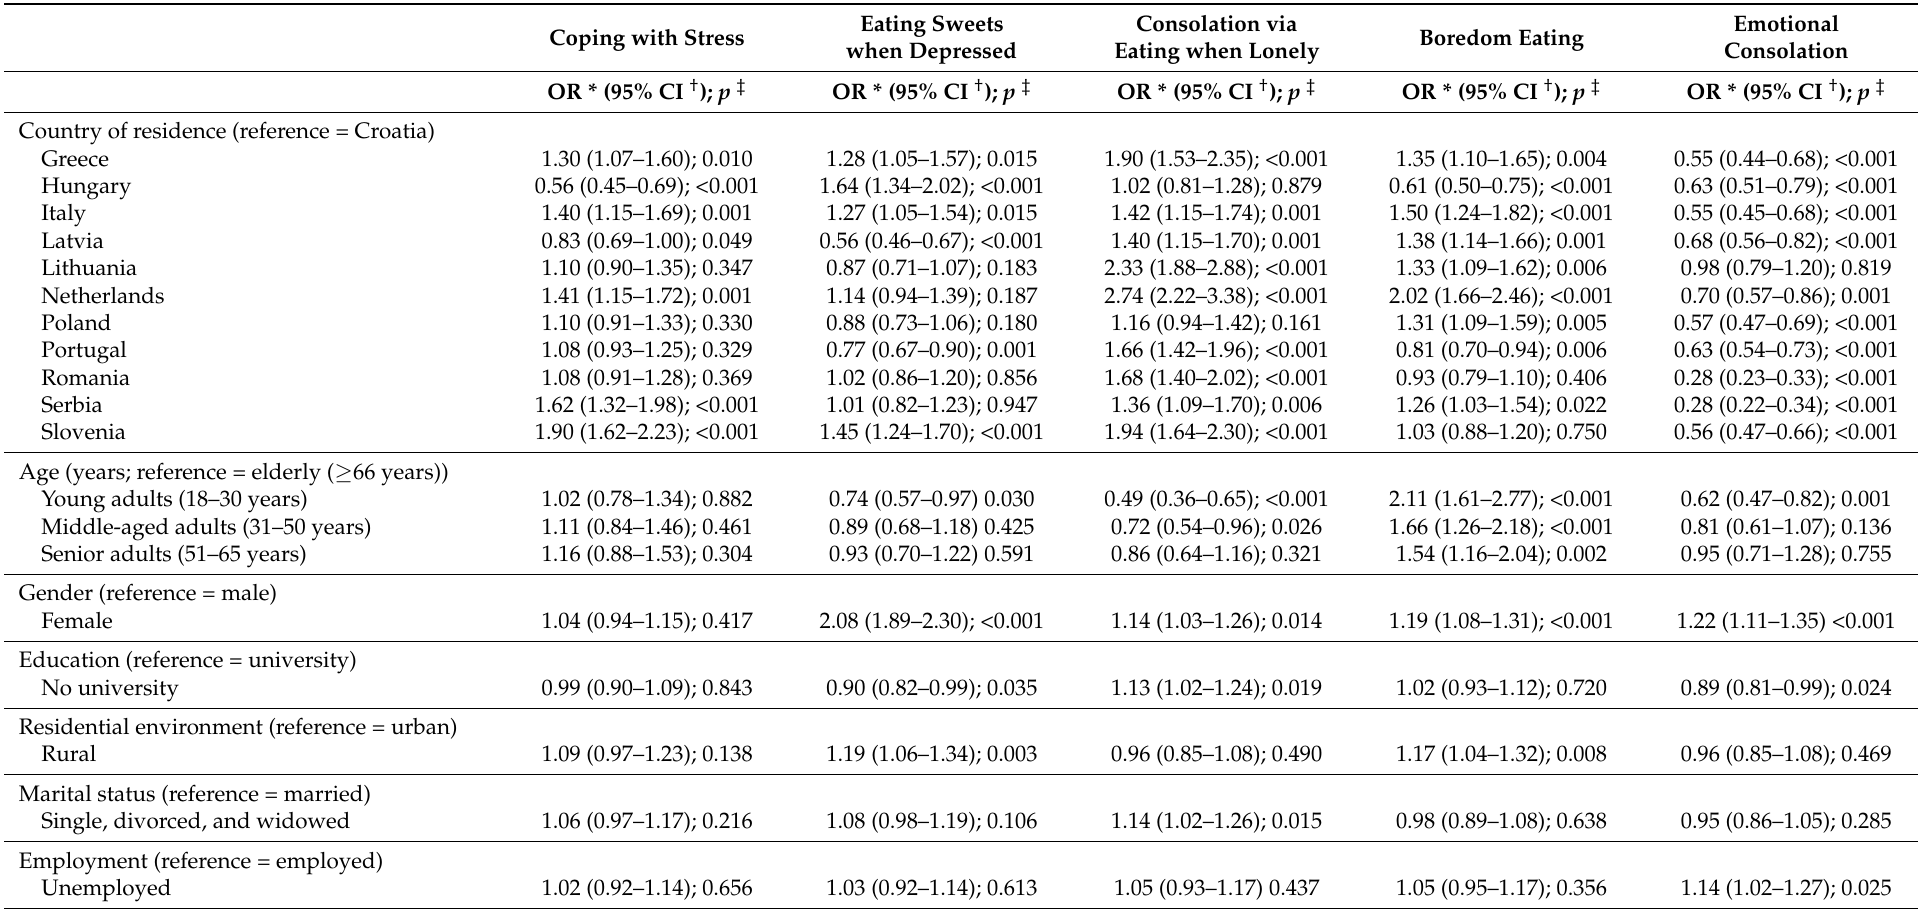
Table 3. Associations between the emotional conditions of food consumption and the respondents’ characteristics using an ordinal regression model, N = 9052. Coping with